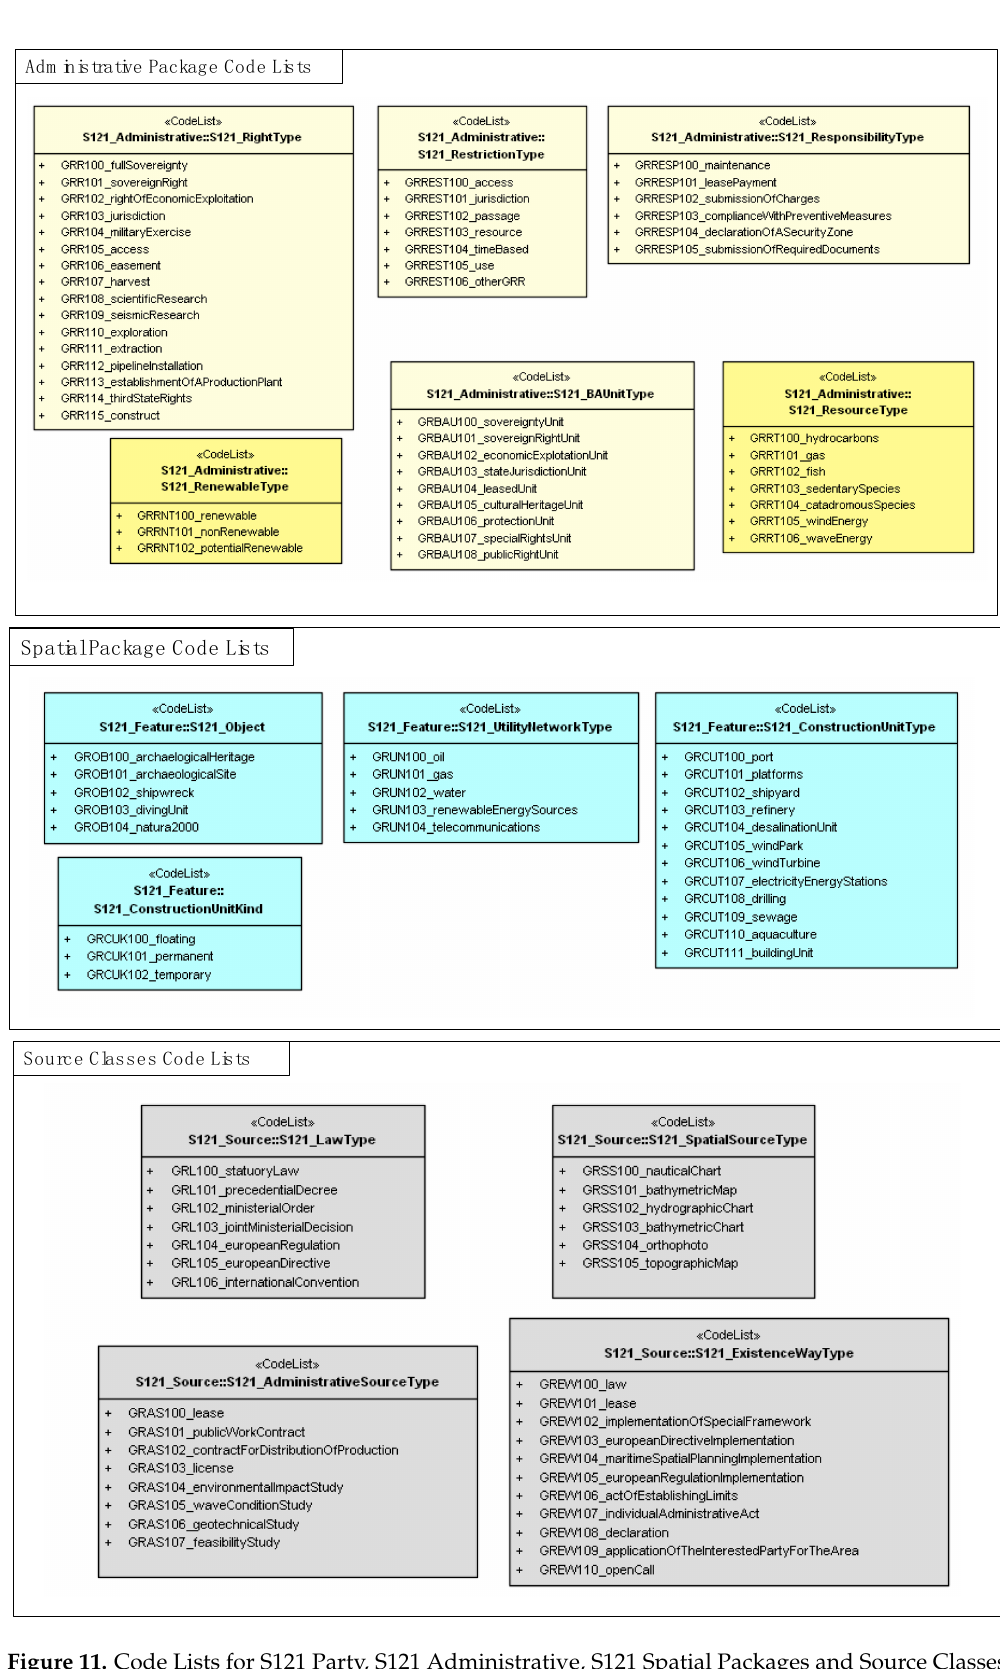
Figure 11. Code Lists for S121 Party, S121 Administrative, S121 Spatial Packages and Source Classes for Greece.